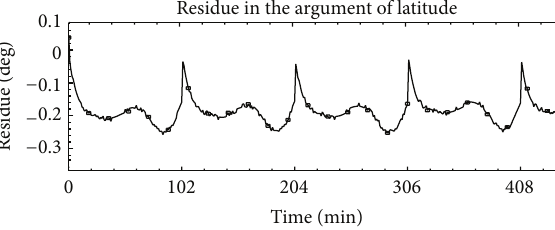
Figure 5: Residue with respect to the polynomial fit.